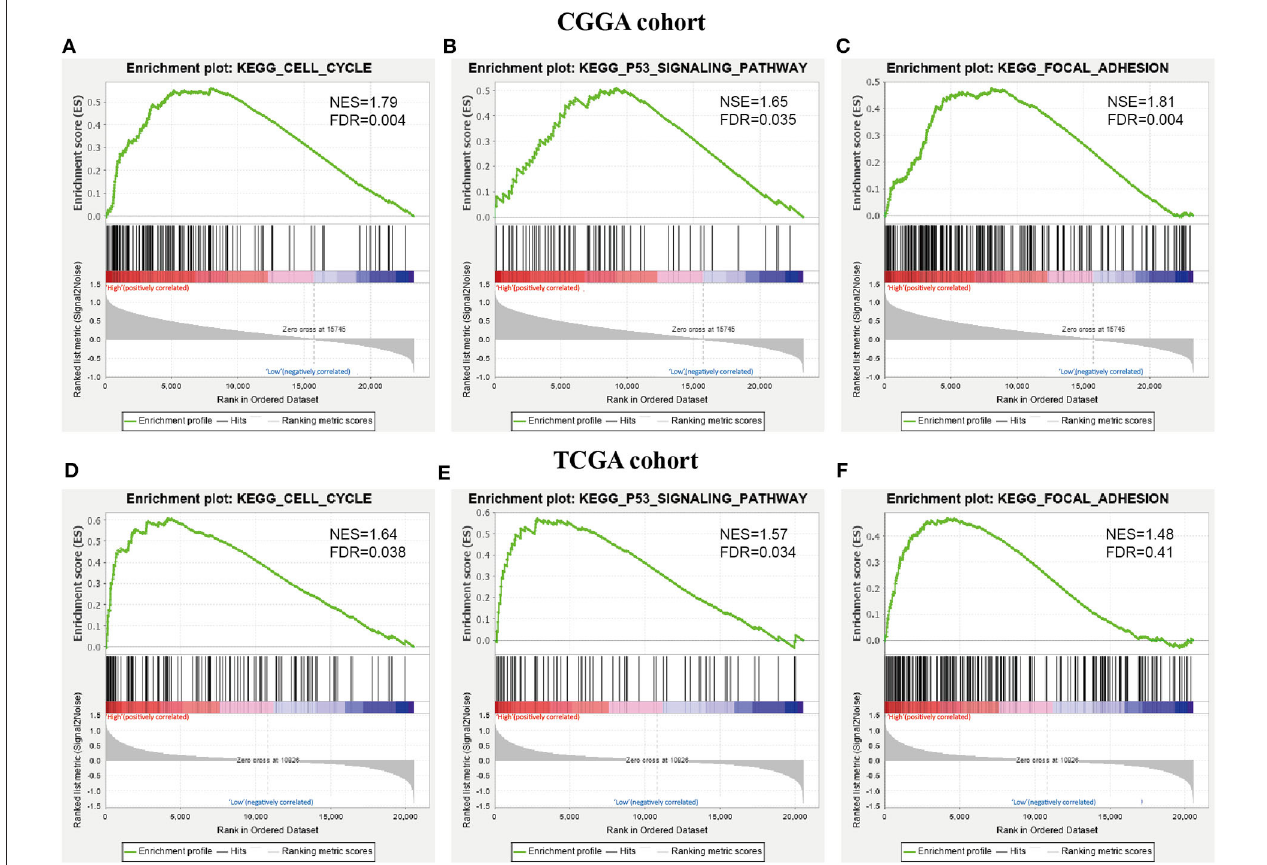
FIGURE 6 | KEGG pathways confirmed by GSEA analysis. (A–C) GSEA was performed to confirm KEGG pathways (cell cycle pathway, p53 signaling pathway, and focal adhesion) in the CGGA cohort. (D–F) GSEA analysis for the three pathways in the TCGA